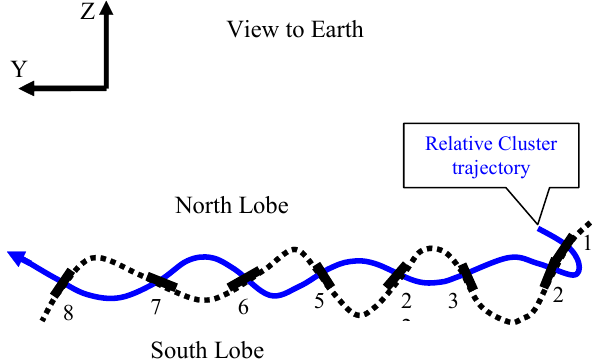
Fig. 3. Schematic illustration of the motion of the neutral sheet Figure 3. Schematic illustration of the motion of the neutral sheet determined from each determined from each individual crossing in the GSM Y-Z plane.